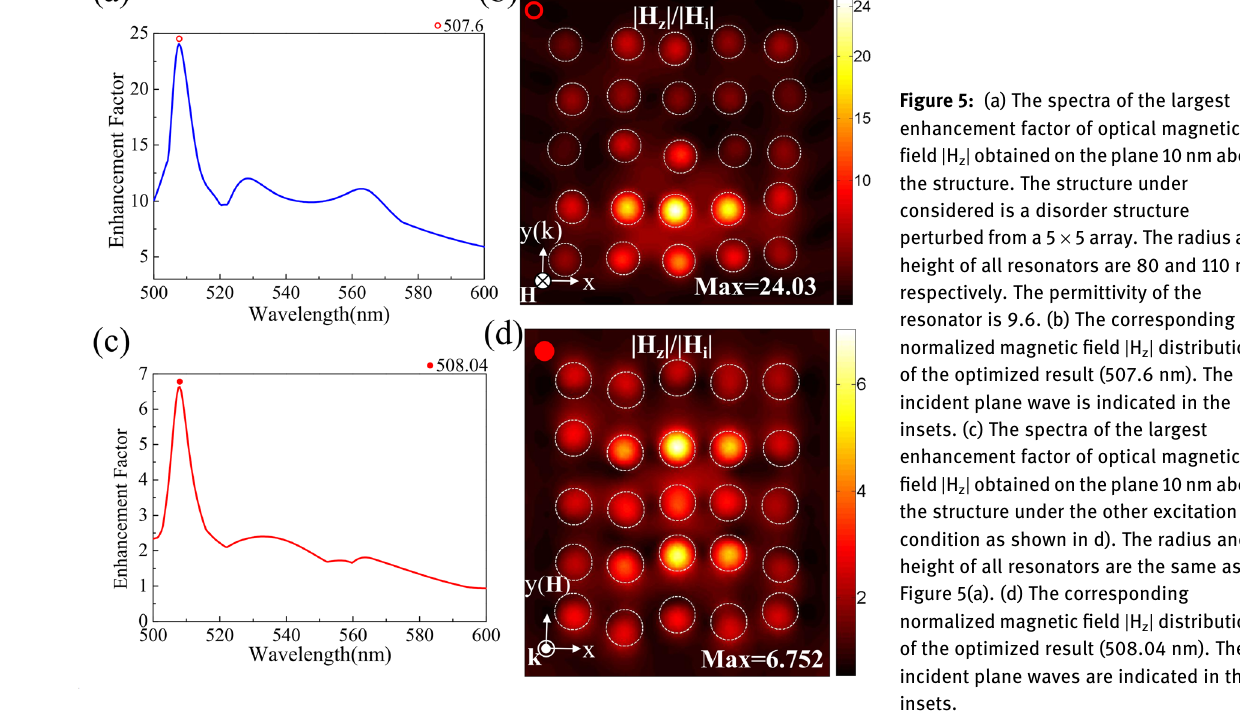
the Figure 4(c) and (d), respectively, where a reasonable agreement between two cases is achieved. In general, the fabricated sample contains parasitic disordered effect.